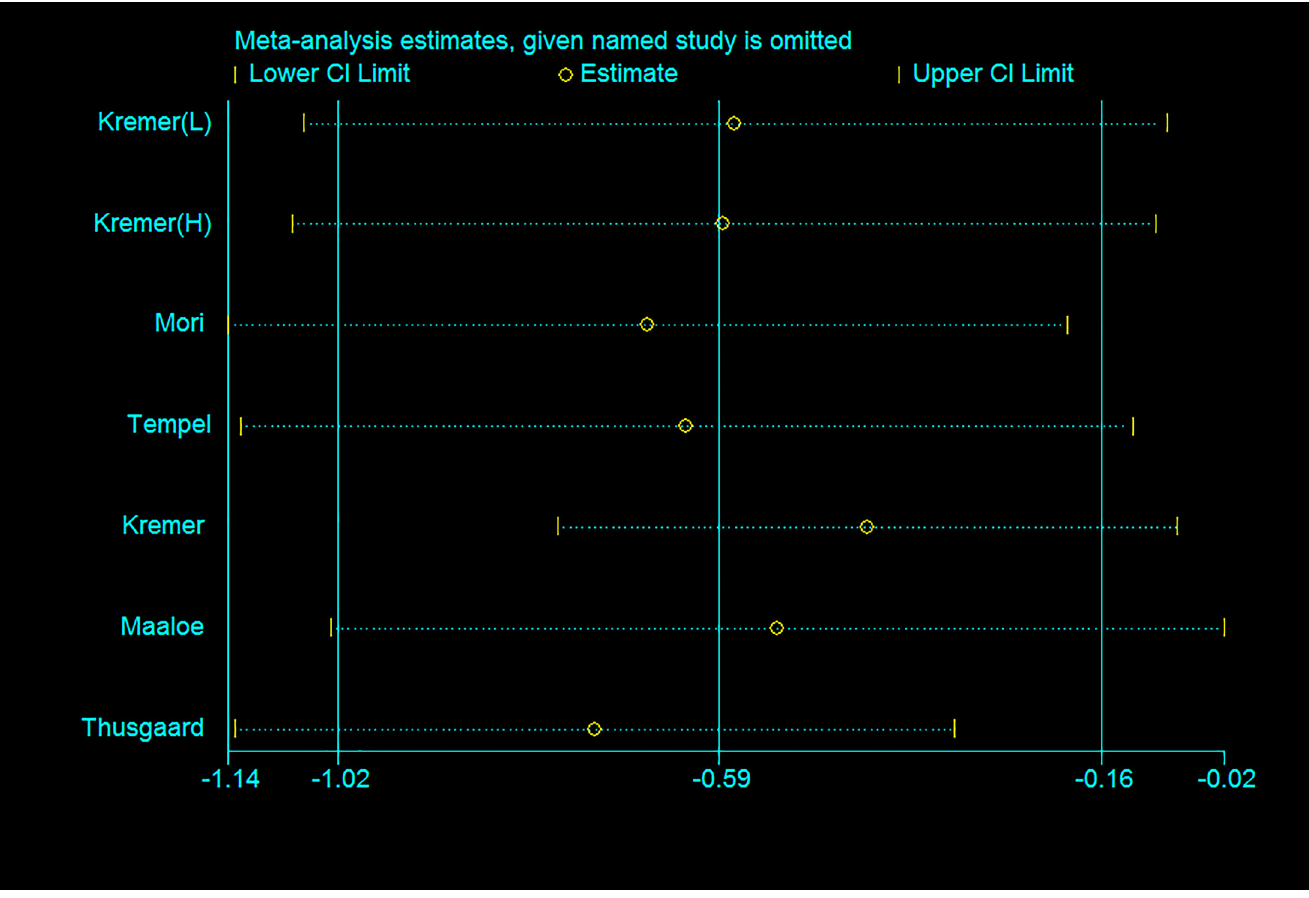
Fig 6. Sensitive analysis with pseudo 95% confidence limits for studies with LTB